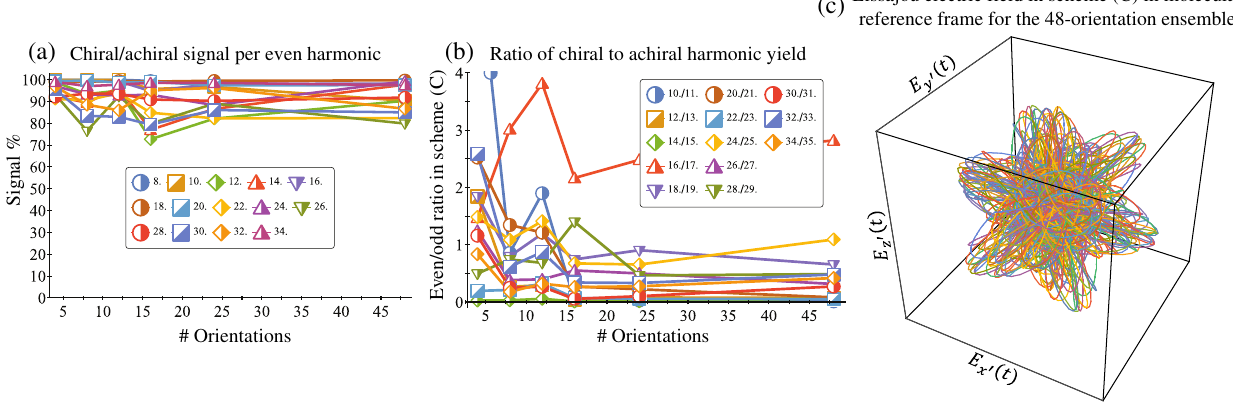
FIG. 8. Convergence with respect to angular grid density in scheme (C) for the DFT-based model, with the same parameters as Fig. 5. (a) Chiral/achiral signal per harmonic order vs orientations. (b) Chiral even harmonic emission ratio to nearby odd achiral harmonic emission. The average ratio is 0.5 for this particular parameter choice. (c) Exemplary representation of the 48-orientation ensemble — the Lissajou curves of the 48 different orientations of pump fields used in the molecular reference frame. As seen, the electric field drives all three spatial axes, even from a single orientation.